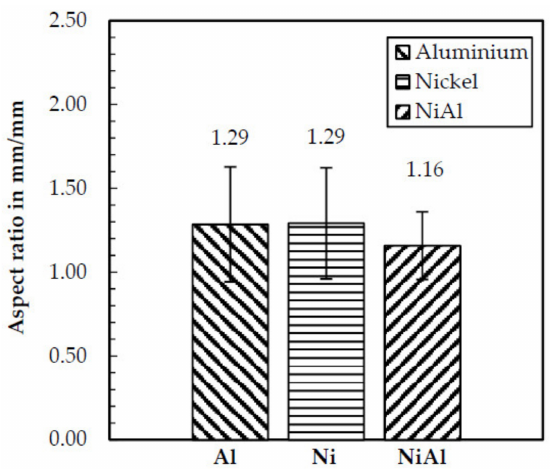
Figure 5. Aspect ratio of the used powders determined by image